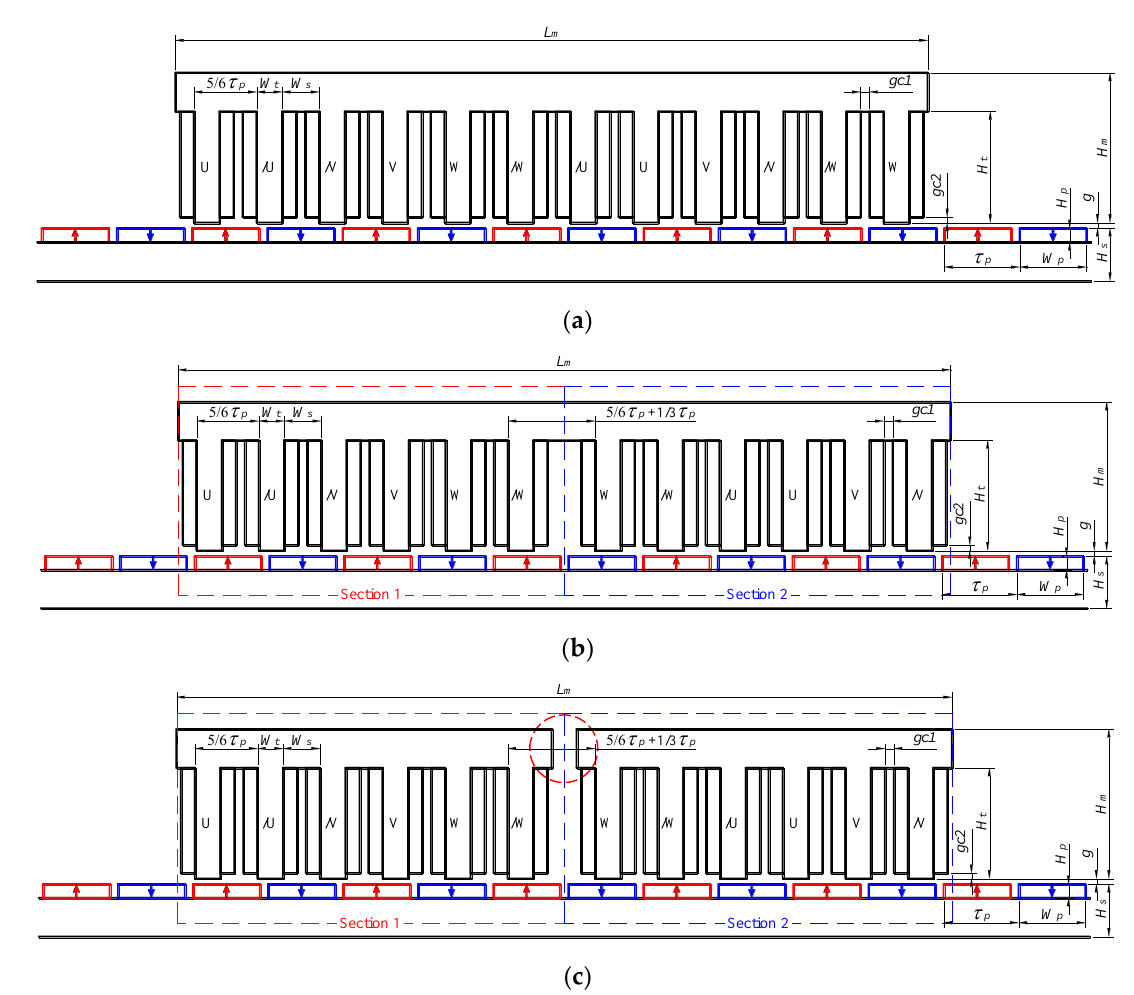
Figure 2. Analysis model geometries: ( a ) Model 1: conventional design; ( b ) Model 2: proposed design; ( c ) Model 3: separated section design.